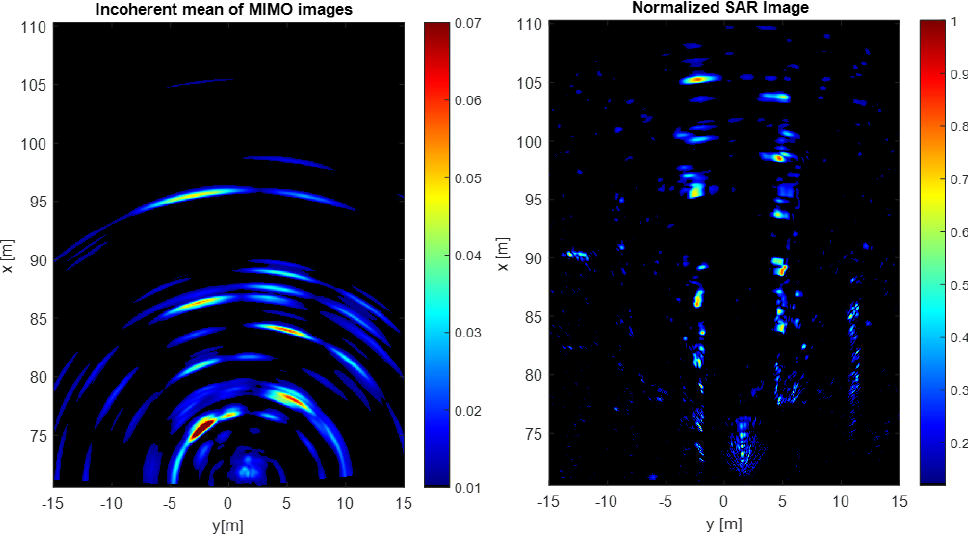
Figure 3. ( Left ) Incoherent mean of 256 MIMO images gathered by a 8 channel radar. ( Right ) Nor- malized SAR image generated by coherently combining the same samples of the left